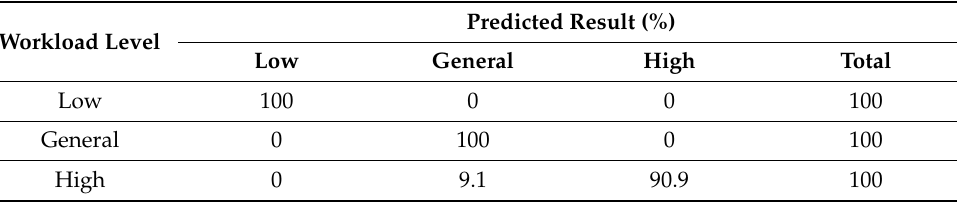
Table 12. The workload discrimination